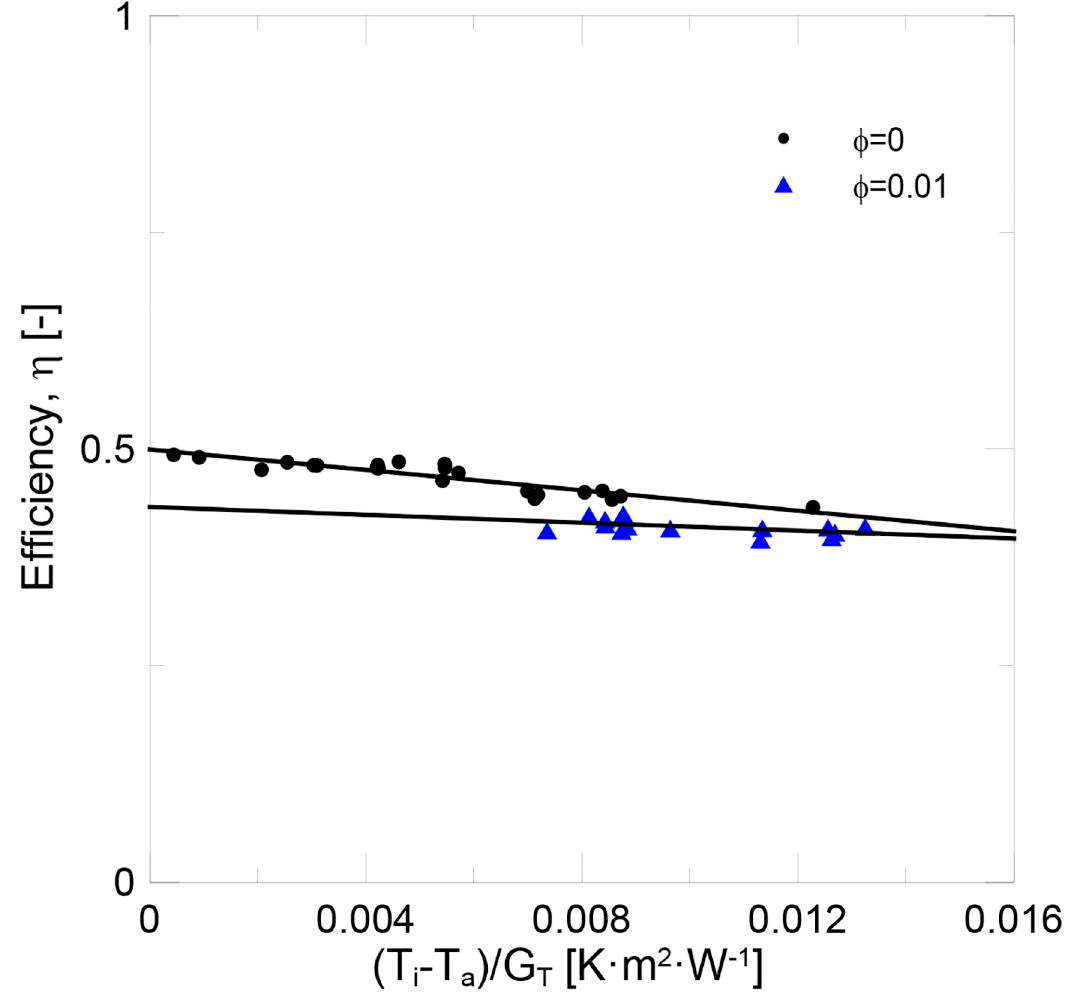
Fig 10. Efficiency for water and the alumina nanofluid at 1 v% (2.4